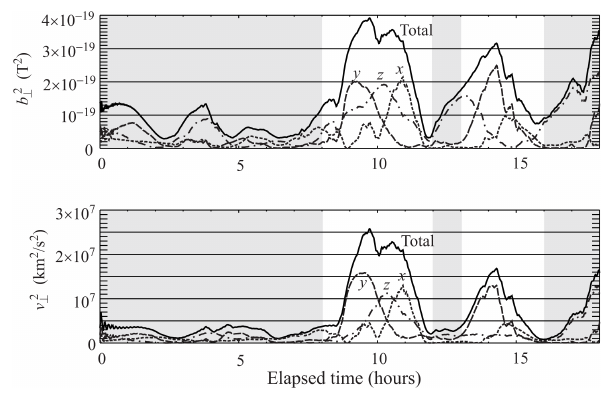
Figure 5. GSM components of the ratio b ⊥ / panel shows the phase and the lower shows the amplitude. Time is measured from 01:31 on 7 June 2000. The unshaded portions of the diagram indicate the peaks in wave energy